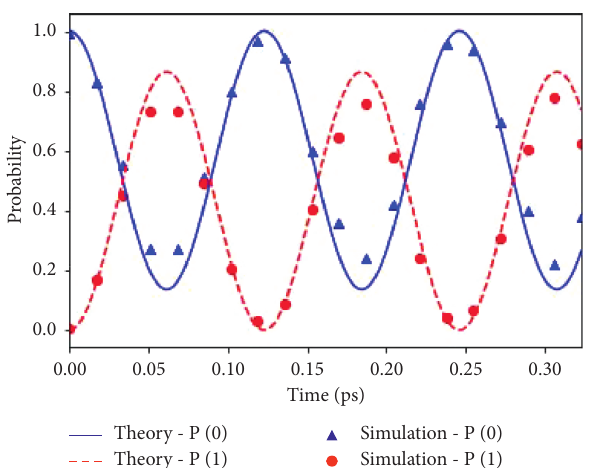
Figure 5: Evolution dynamics of the isolated system obtained by employing the quantum algorithm for the near-resonant system: simulation results (points) and theory (lines).